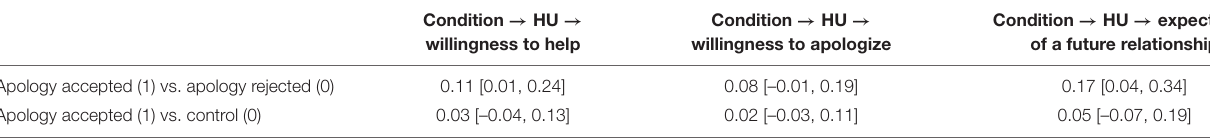
TABLE 6 | Indirect effects of condition on relationship outcome measures through human uniqueness (HU) (Study 2).